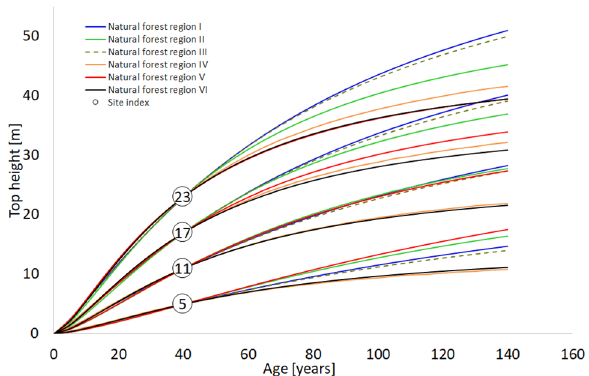
Figure 6. Top height trajectories estimated from the regional fixed-effects model for Scots pines in six natural forest regions (base age 40